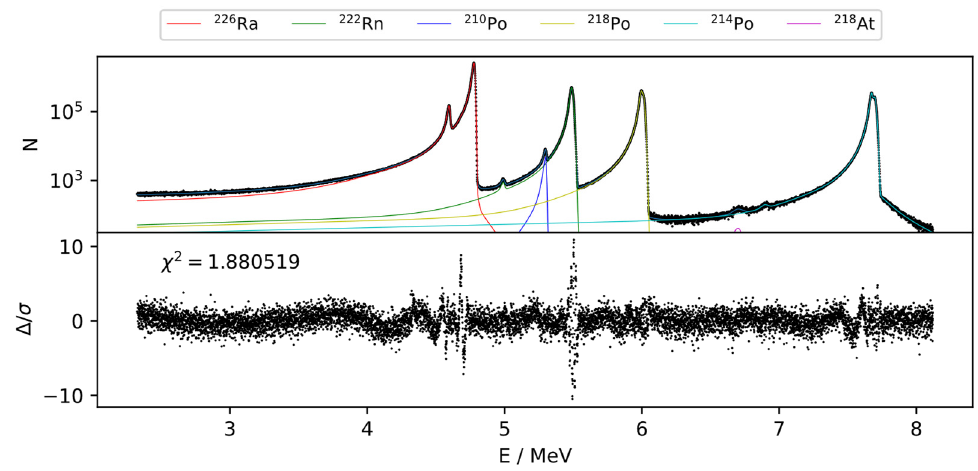
Figure 5. Typical α -particle spectrum obtained with a 442 Bq 226 Ra IRSD (modified Canberra PIPS ® detector of nominal 100 µm depletion depth, 450 mm 2 active area), over the first 6 ⋅ 10 5 s after modification and regression results, according to Section 2.4.3. The 4.8 MeV 226 Ra emission shows a FWHM of approx. 21 keV and a FWTM of approx. 48 keV. Progeny peaks appear slightly shifted to higher energies (wrt. the energy calibration obtained from the 226 Ra